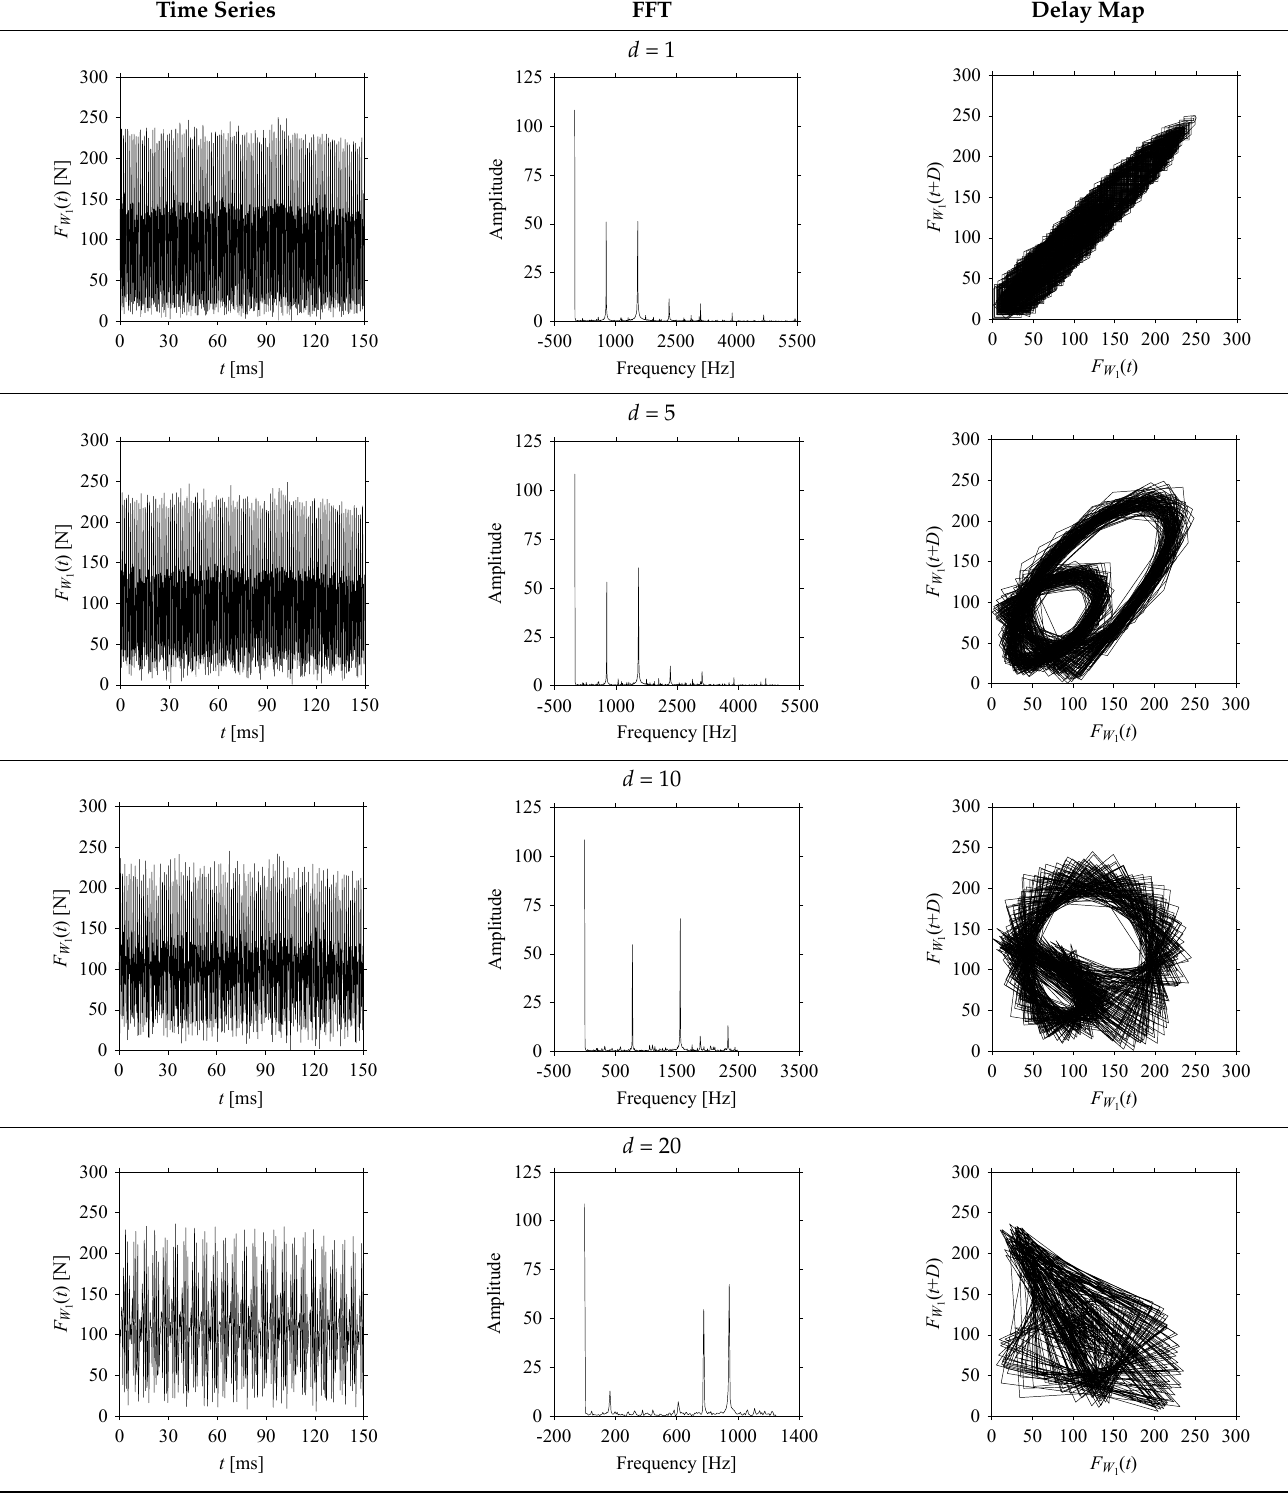
Table 2. F W in the form of time series, FFT, and delay map under varying delay ( d ).